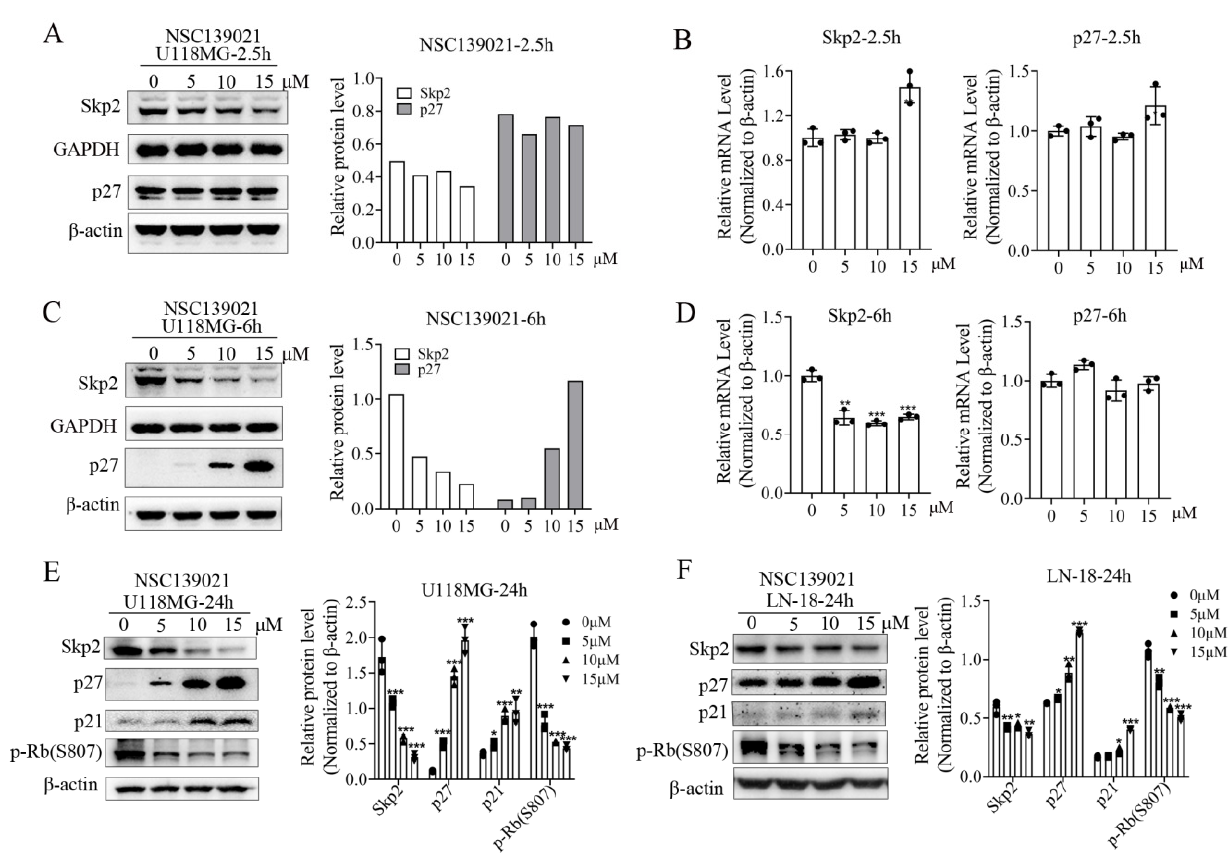
Figure 3. NSC139021 suppressed G1/S transition and cell cycle progression in glioblastoma cells via inhibiting the Skp2- p27/p21 axis. ( A ) Western blot analysis showed that NSC139021 (5, 10, 15 µ M) treatment for 2.5 h downregulated the protein expression level of Skp2 but did not affect CDK inhibitor p27. The protein level was quantified and normalized to GAPDH or β -actin and plotted on the right panel. ( B ) Real-time PCR analysis showed that NSC139021 (5, 10, 15 µ M) treatment for 2.5 h did not affect the mRNA expression level of Skp2 and p27. ( C ) Western blot analysis showed that NSC139021 (5, 10, 15 µ M) treatment for 6 h also downregulated the protein expression level of Skp2 and upregulated the protein expression level of p27. The protein level was quantified and normalized to GAPDH or β -actin and plotted on the right panel ( D ). Real-time PCR analysis showed that NSC139021 (5, 10, 15 µ M) treatment for 6 h downregulated the mRNA expression level of Skp2 but did not affect p27. ( E , F ) Western blot analysis showed that NSC139021 (5, 10, 15 µ M) treatment for 24 h also downregulated the protein expression level of Skp2 and p-Rb (S807), upregulated the protein expression level of p27 and p21 in U118MG and LN-18 cells. β -actin was used as an internal control. The protein levels were quantified and normalized to β -actin and plotted on the right panel. The data were represented as the mean ± SD of three independent experiments.* p < 0.05, ** p < 0.01, *** p < 0.001 when compared to the DMSO